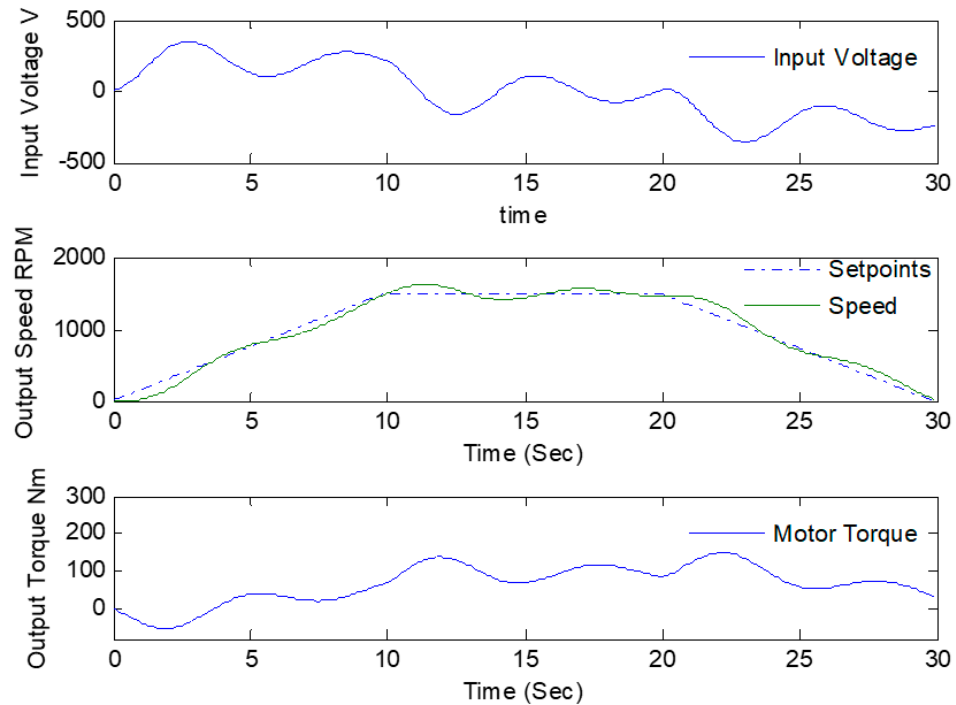
Figure 6. The MPC for the HEV with N p = 5 and Q = R .